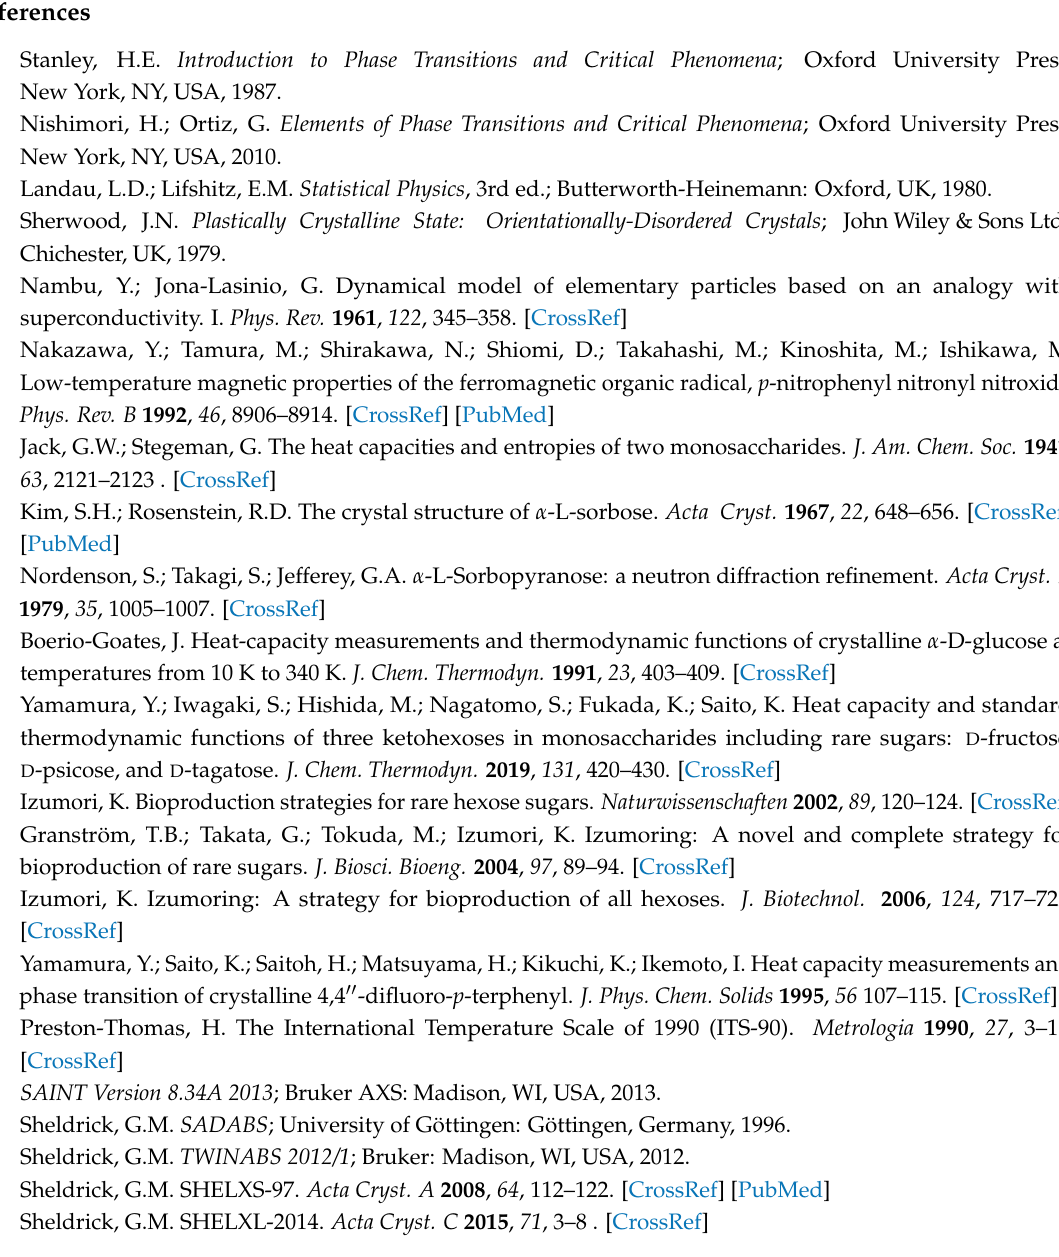
Table S1: Experimental heat capacities of crystalline D -sorbose, Table S2: Standard thermodynamic quantities of crystalline D -sorbose at round temperatures, Table S3: Summary of the structure analyses of D -sorbose at 100 K, 210 K, and 295